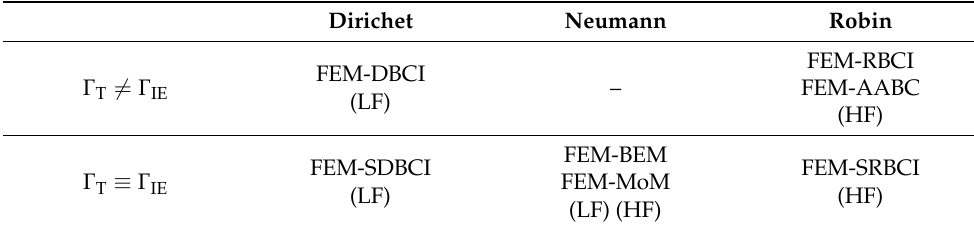
Table 1. Various FEM-IE methods. Dirichet Neumann